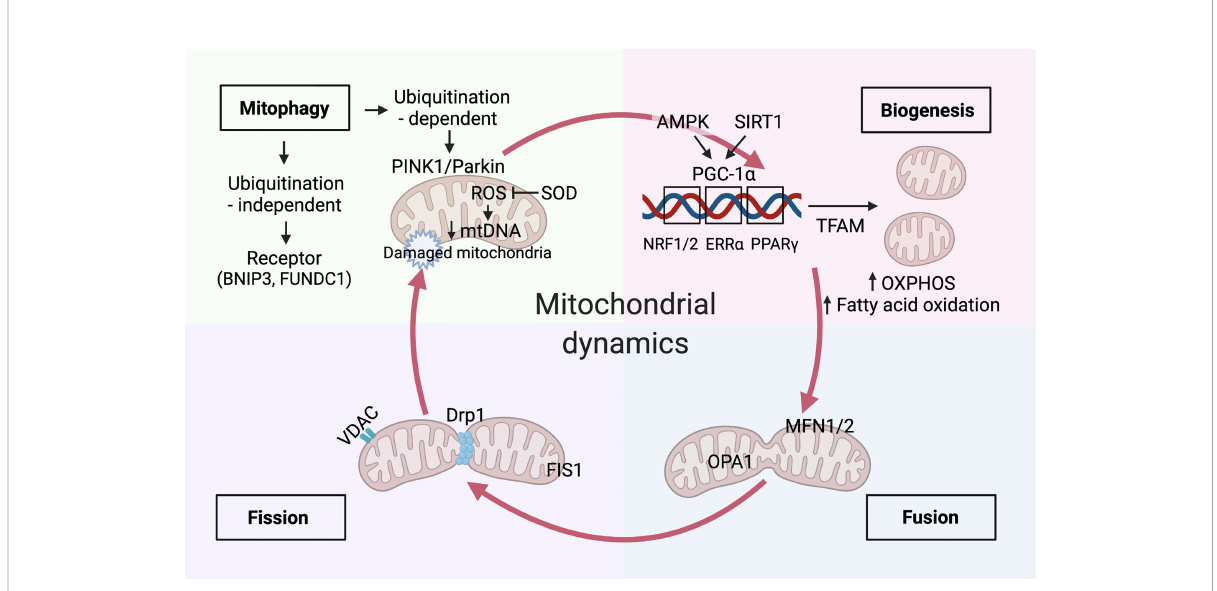
FIGURE 2 Mitochondria dynamics balanced with biogenesis and mitophagy. Mitochondrial biogenesis. Immune signals of AMP-activated protein kinase (AMPK) and sirtuin 1 (SIRT1) have been reported to increase mitochondrial biogenesis by peroxisome proliferator-activated receptor- g coactivator-1 a (PGC-1 a ). The master regulator, PGC-1 a , drives mitochondrial biogenesis, oxidative phosphorylation(OXPHOS), and fatty acid oxidation by co-activating transcription factors, including Estrogen Related Receptor Alpha (ERR a ), peroxisome proliferator-activated receptor (PPAR)- g , nuclear respiratory factor (NRF)-1 and-2. Mitochondrial transcription factor A(TFAM) aids in the transcription of genes that is essential for balancing mtDNA transcription and clearance. Mitochondrial dynamics. Mitochondrial dynamics of fi ssion and fusion are regulated by dynamin-related protein-1 (Drp1), fi ssion 1 (Fis1) and mitofusin-1 (Mfn1), mitofusin-2 (Mfn2), and optic atrophy 1 (Opa1) respectively. mtDNA extrudes from the mitochondria through pores formed by voltage-dependent anion-selective channel (VDAC) oligomers. Mitophagy activation. The augment of fi ssion promotes mitophagy activation by the PTEN-induced kinase 1 (PINK1)/Parkin-mediated ubiquitination pathway and receptor-mediated pathways, such as BCL2 interacting protein 3 (BNIP3) and FUN14 domain-containing protein 1(FUNDC1). Timely elimination of damaged and aged mitochondria reduces the excessive accumulation of mitochondria reactive oxygen species (mROS), which can be inhibited by mitochondrial enzymes such as superoxide dismutase 2 (SOD2). Damaged mitochondria with decreased mtDNA undergo